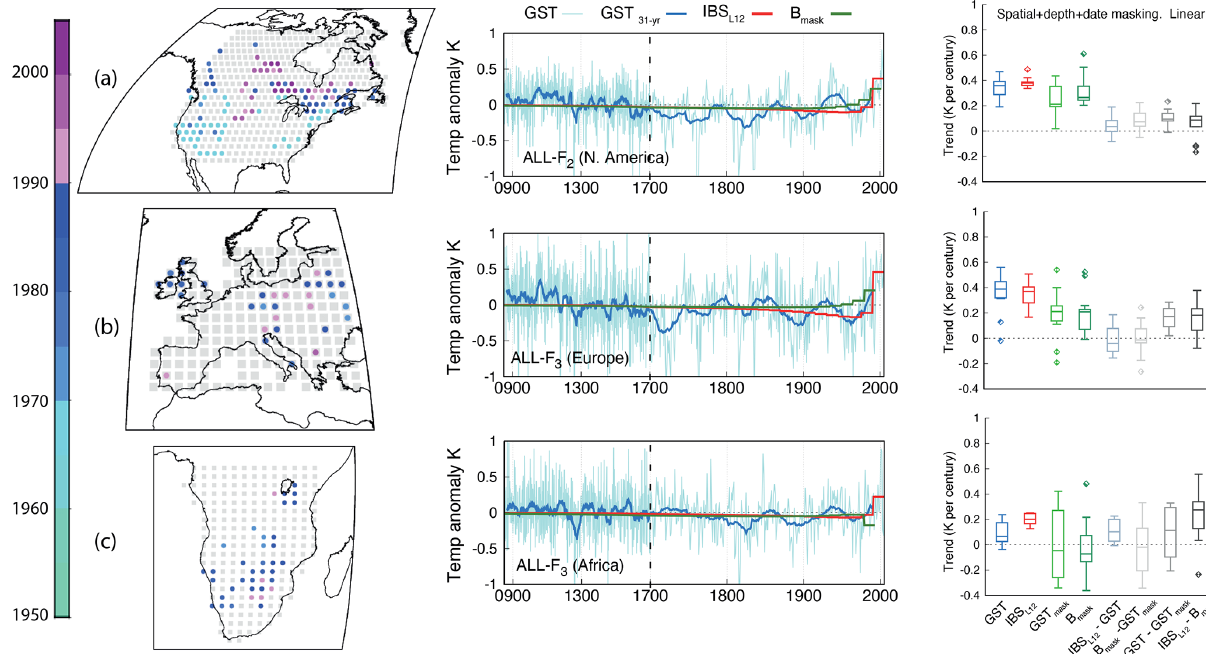
Figure 3. LM global GST annual anomalies and pseudo-reconstructions for three different subcontinental regions: (a) North America (31.26– 69.16 ◦ N, 135–55 ◦ W), (b) Europe (36.59–59.68 ◦ N, 10 ◦ W–30 ◦ E) and (c) Africa (35.05 ◦ S–2.28 ◦ N, 10–40 ◦ E). The ALL- F 2 member is displayed for the North American continent, whereas the ALL- F 3 member of the ALL-F ensemble is used for the European and African regions. Maps in (a)–(c) show the spatial distribution of BTP locations and dates of the actual borehole network for each of the regions. Grey dots show the model grid and the areas defining each of the regions. Right panels: as in Fig. 2a and b but with the 1900–2005CE trends presented for only the linear fit method.